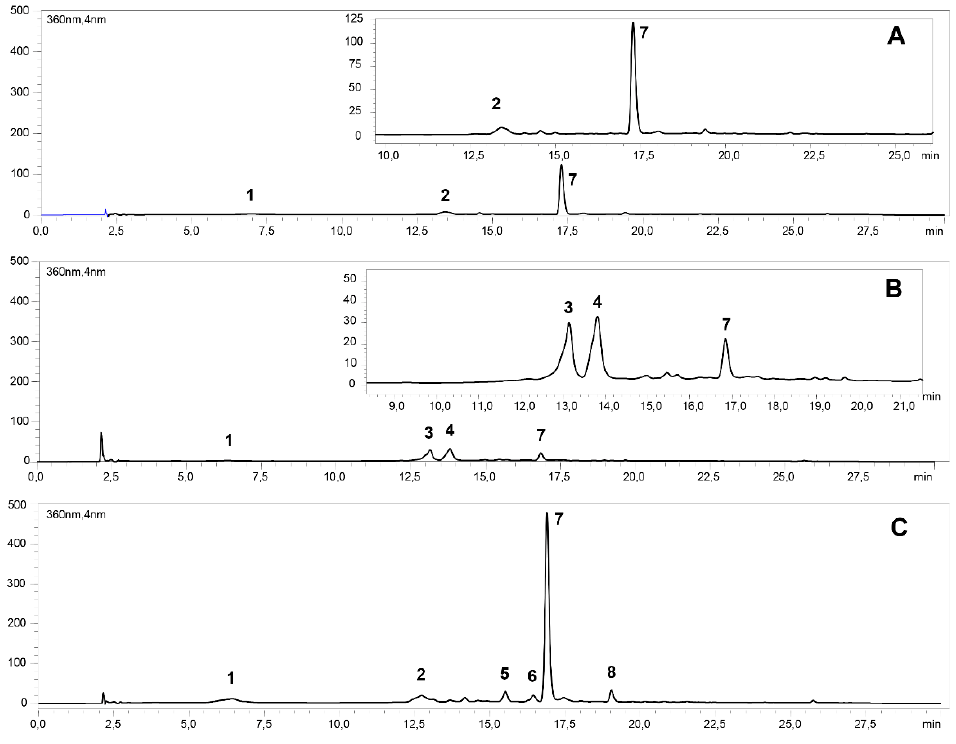
Figure 1. HPLC-DAD chromatogram at 360 nm of hydroxycinnamic acid derivatives and flavonols in Solanum tuberosum leaves under the treatment of fungicides and arbuscular mycorrhizal fungi, where: ( A ) VR808 genotype ( B ) CB2011-509 genotype ( C ), CB2011-104 genotype. For identification, please refer to details in Table 1. Table 1. Identifications of phenolic compounds in Solanum tuberosum leaves by HPLC-DAD-ESI- MS/MS.